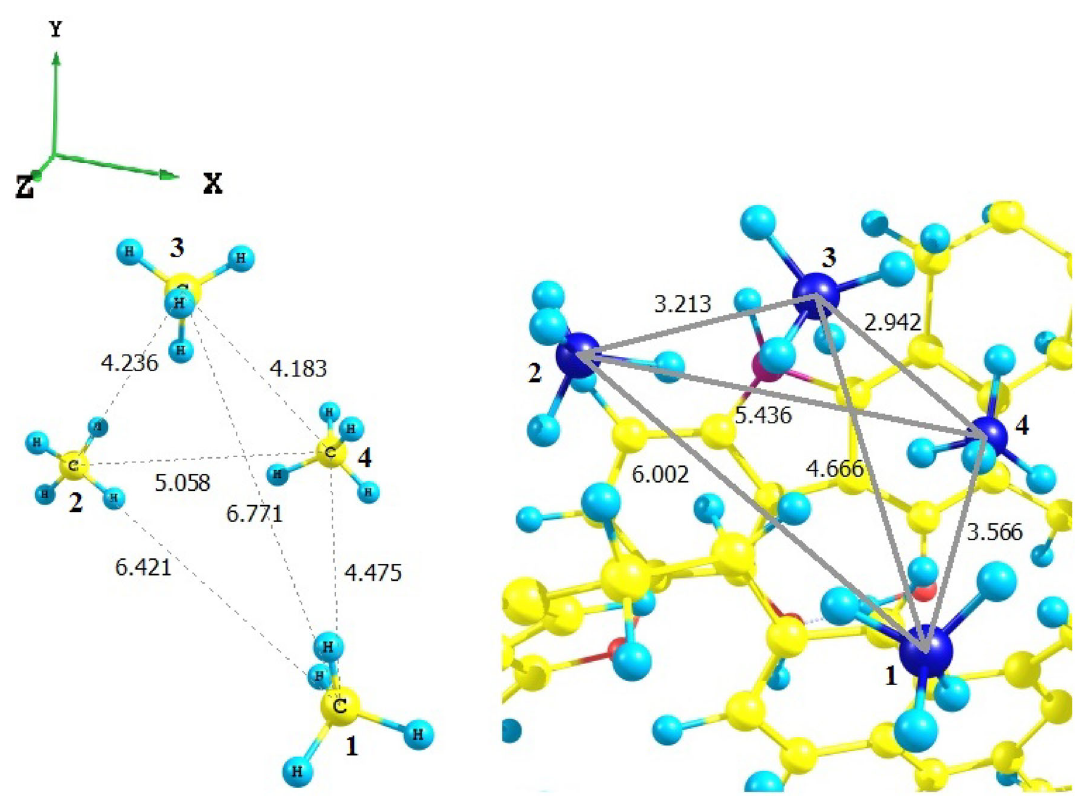
Fig. 4 Methane tetramer (distances are given in A˚